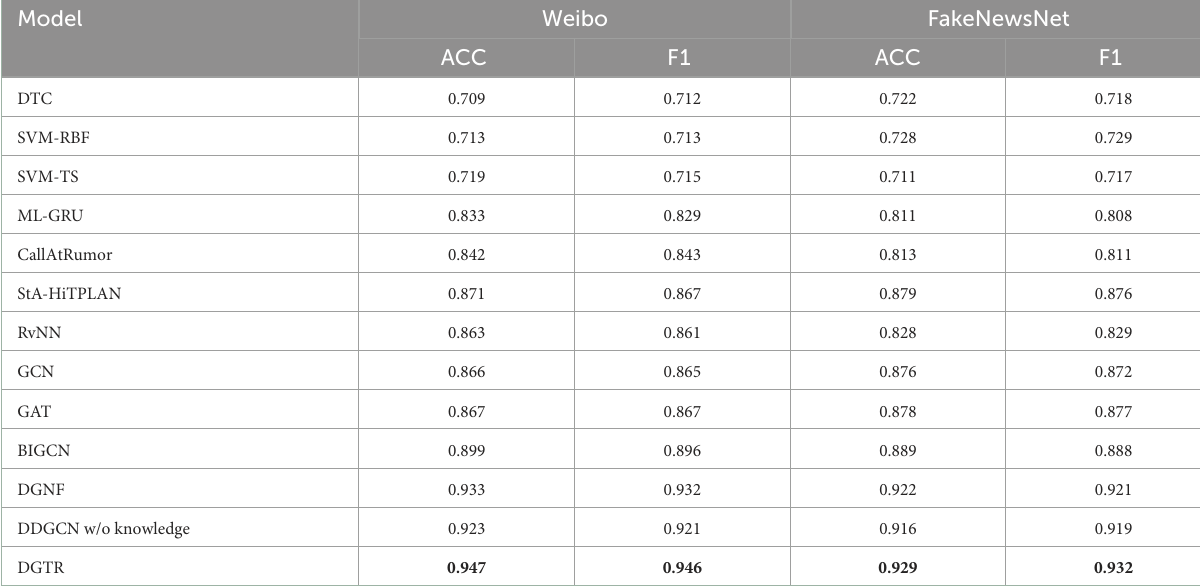
TABLE 2 Performance comparisons of different methods on Weibo and FakeNewsNet datasets.